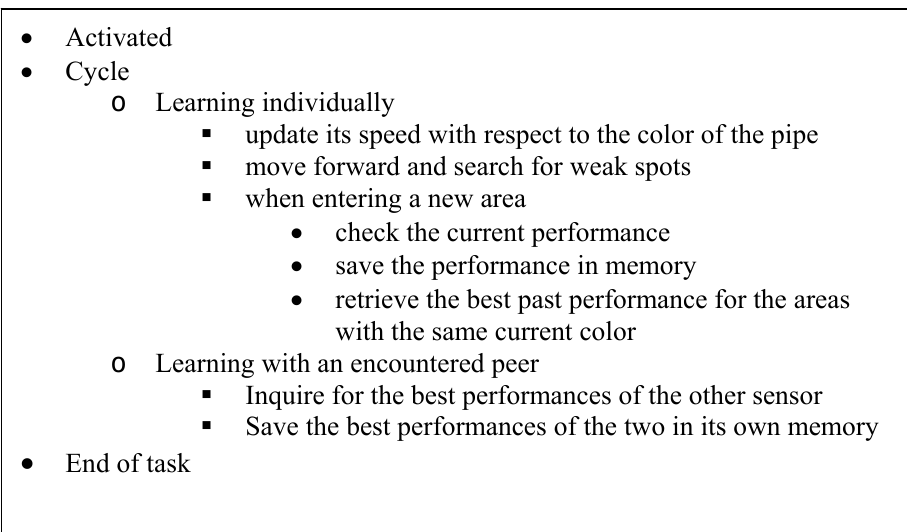
Figure 4. Working cycle of a mobile